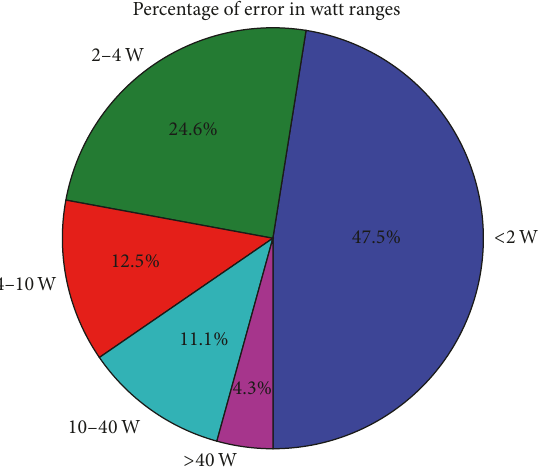
Figure 2: A model fitness graph for Max Power Point (MPP) target versus prediction analysis of a standard, normalized input ANN. Black lines and grey boxes have been added to the diagram to identify and assess target/prediction outliers with high error values.